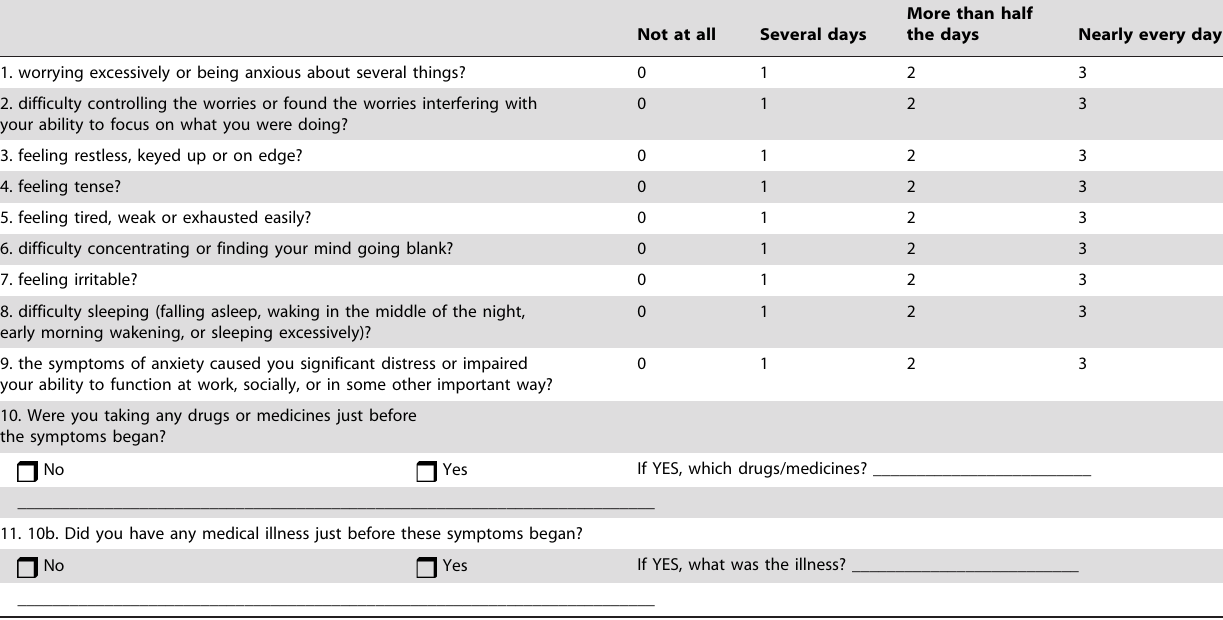
Table 1. Generalized Anxiety Disorder Scale.